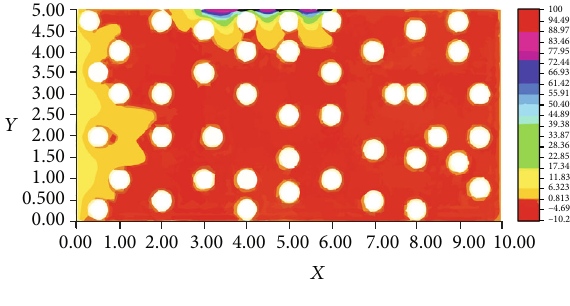
Figure 10: Pressure distribution at Re = 10 .